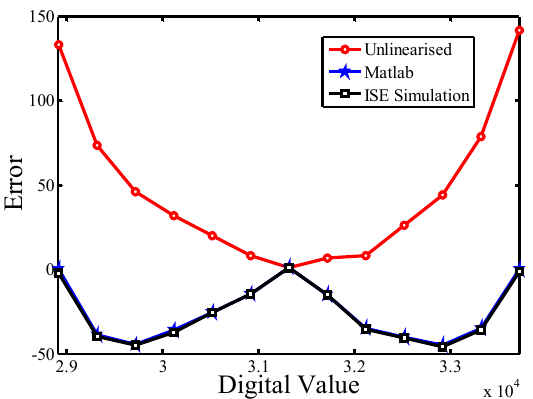
Figure 9. Inaccuracy of the unlinearized sensor and estimated inaccuracies of theoretical model using Matlab and ISE simulation for the proposed linearization.